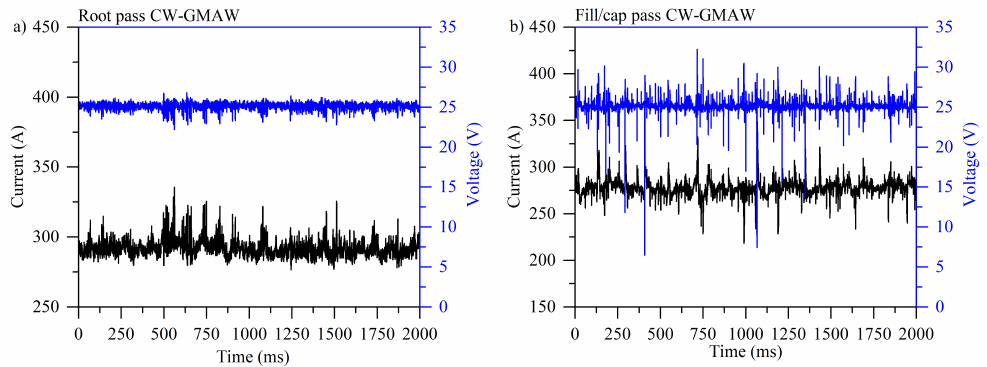
Figure 3. Typical oscillograms for the CW-GMAW condition: ( a ) root pass; and ( b ) fill/cap